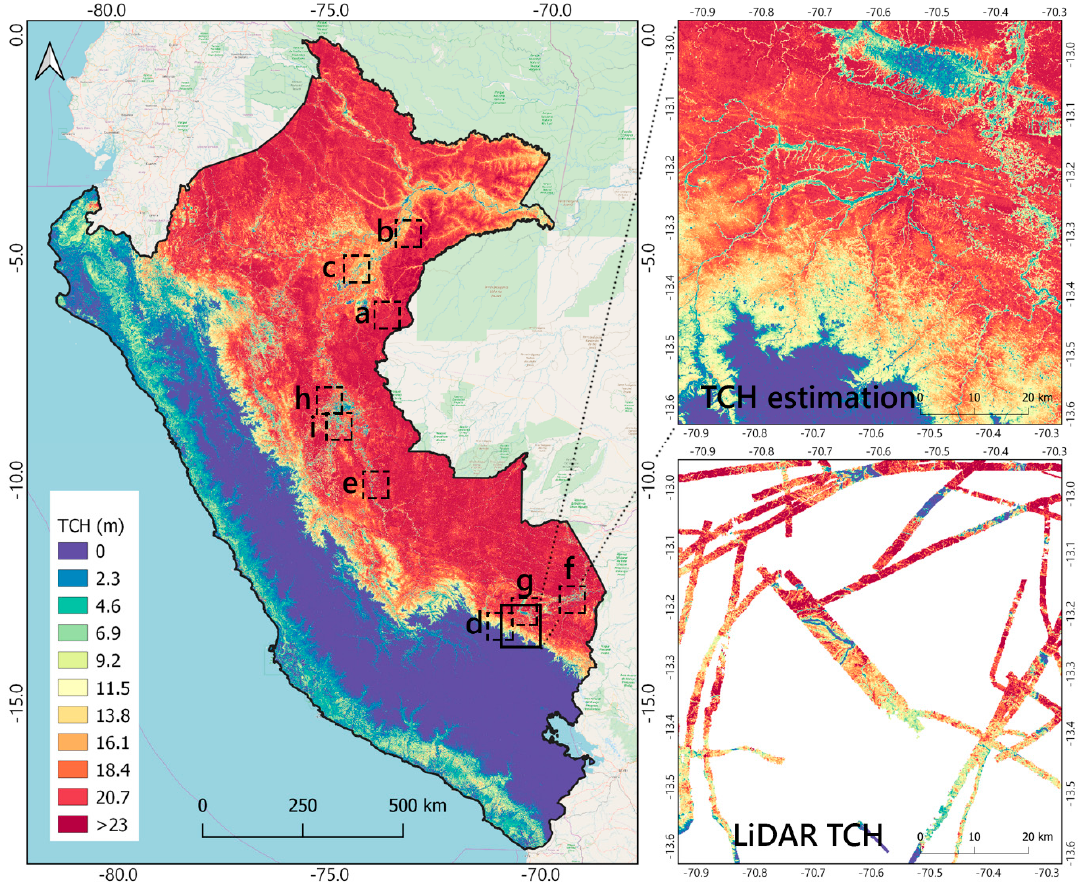
Figure 6. The TCH estimation map of Peru at 1 ha spatial resolution (100 × 100 m pixels) with subsets (a–i) shown in Figure 7. A comparison between our TCH estimation and transects of airborne LiDAR TCH is shown on the right side of the figure.